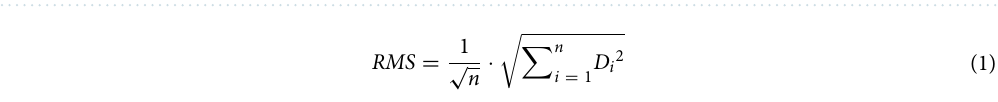
Figure 1. Procedure for intaglio surface trueness of interim crowns fabricated from tooth preparation scanned at four finish